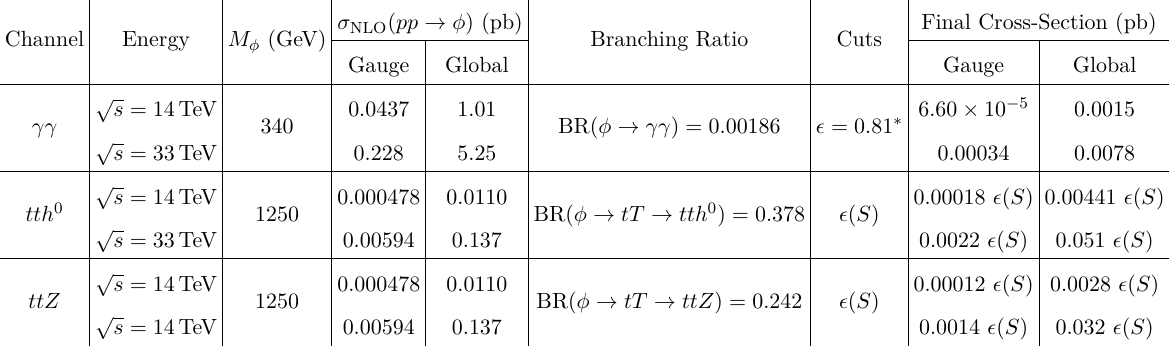
Table 2. Table of cross-sections for Yukon φ production and decay in various channels, with cuts on the signal processes. Note all signals are calculated at LO, then multiplied by a k -factor of k NLO = 1 . 7 to get the written NLO results: S NLO = S LO × k NLO . The parameter set used in all cases is as follows: { θ Q = π/ 4 , ϕ u = 0 , ϕ d = π, g 0 = 1 } . Gauged model fixes M Z 0 = 3 TeV, 34 whereas global model fixes v φ = 625 GeV. Results for v φ = 625 are a factor (3000 / 625) 2 ’ 23 larger than the M Z 0 = 3 TeV ones in all cases, since σ NLO ( pp → φ ) ∝ v − 2 and BRs are independent of v φ φ